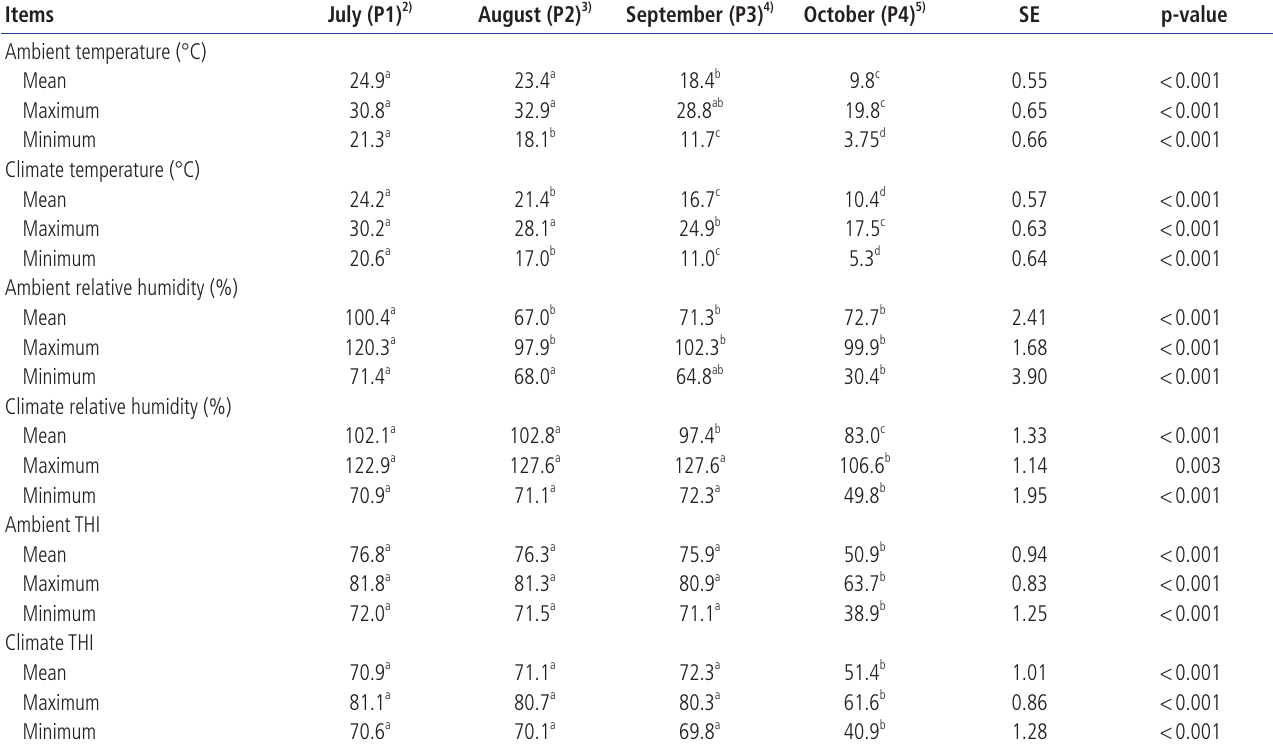
Table 2. Mean, maximum, and minimum values of ambient temperature, climate temperature, relative humidity, and temperature-humidity index 1) at July to October